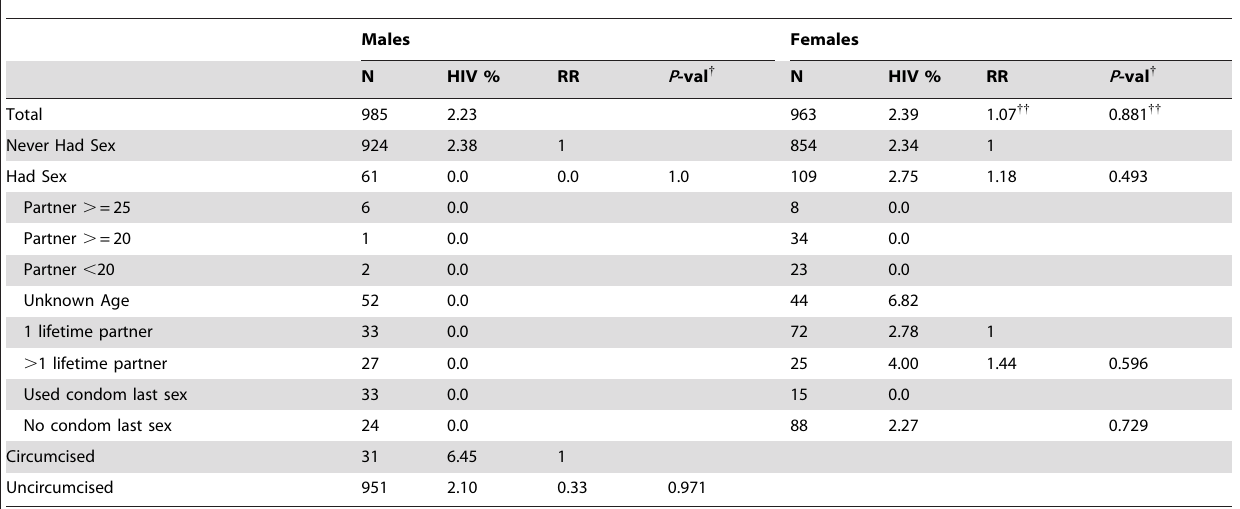
Table 3. Individual Risk Factors for Adolescent Sexual HIV